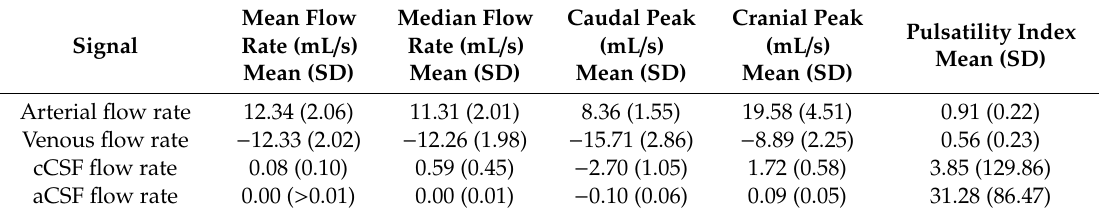
Table 3. Mean signal correlation r values for all the subjects aggregated together.